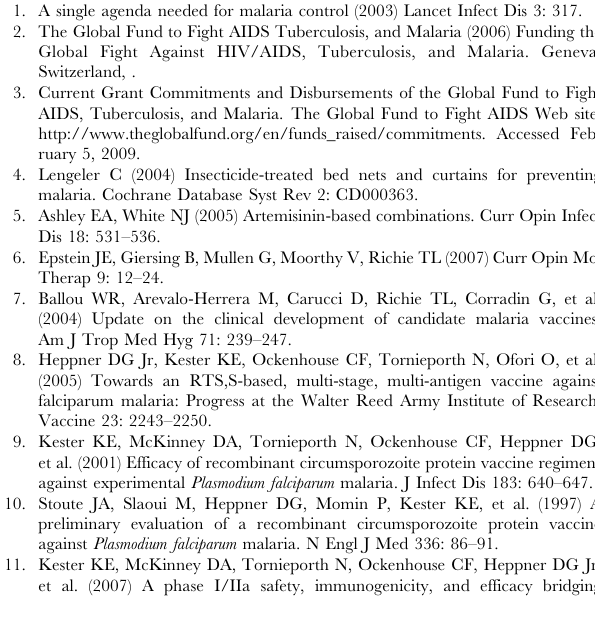
Table S2 CSP 3D7/non 3D7 type by polymorphic amino acid site in Th3r (single + majority) (ATP cohort for efficacy)